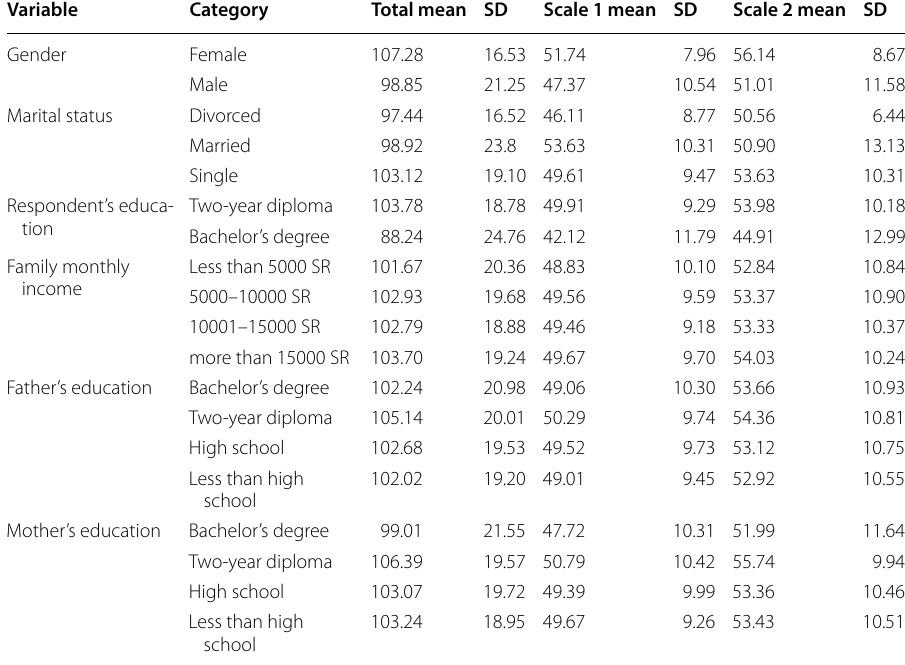
Table 5 Mean questionnaire and subscale scores according to socio-demographic group